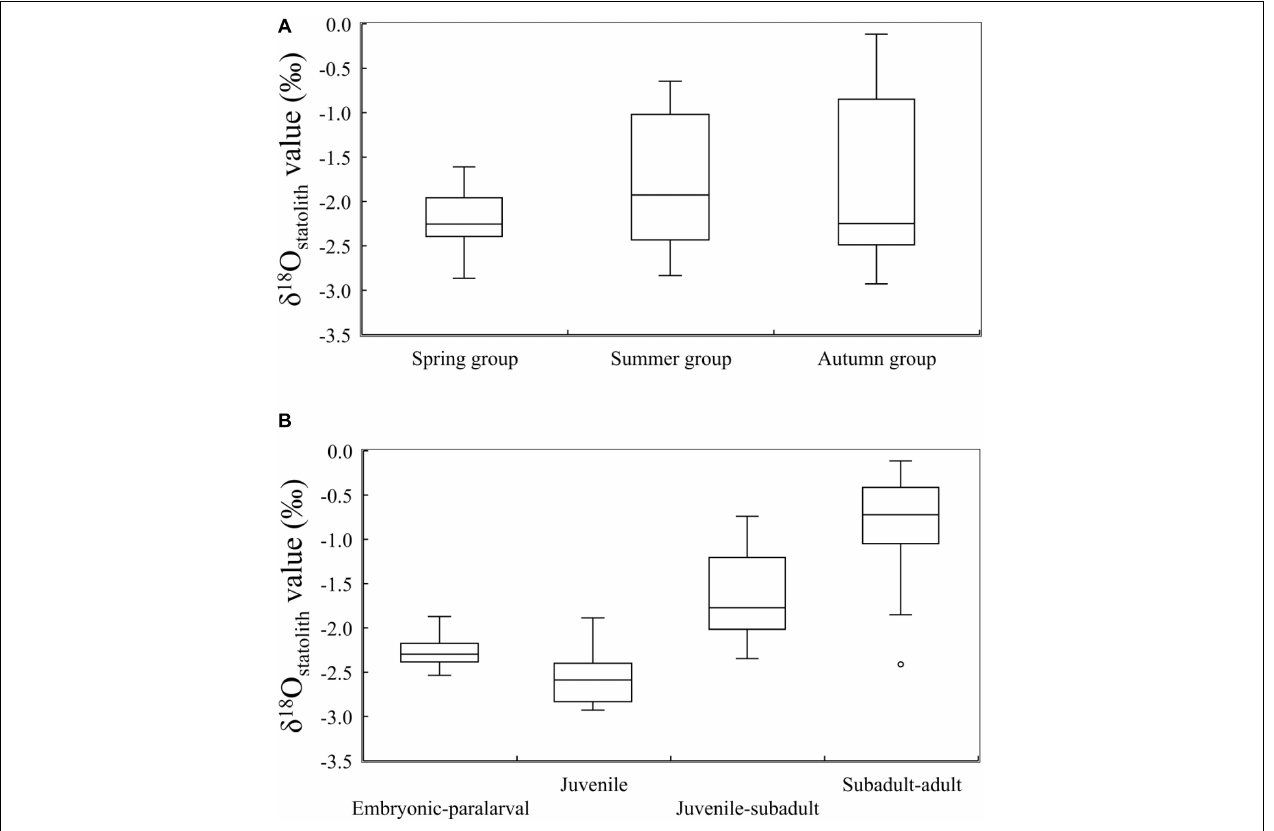
FIGURE 4 | δ 18 O statolith values in S. lessoniana (A) in three seasonal groups and (B) at four ontogenetic stages. The box plots show the interquartile range, with the median value indicated by the horizontal line; whiskers show the range. Circles indicate outliers.